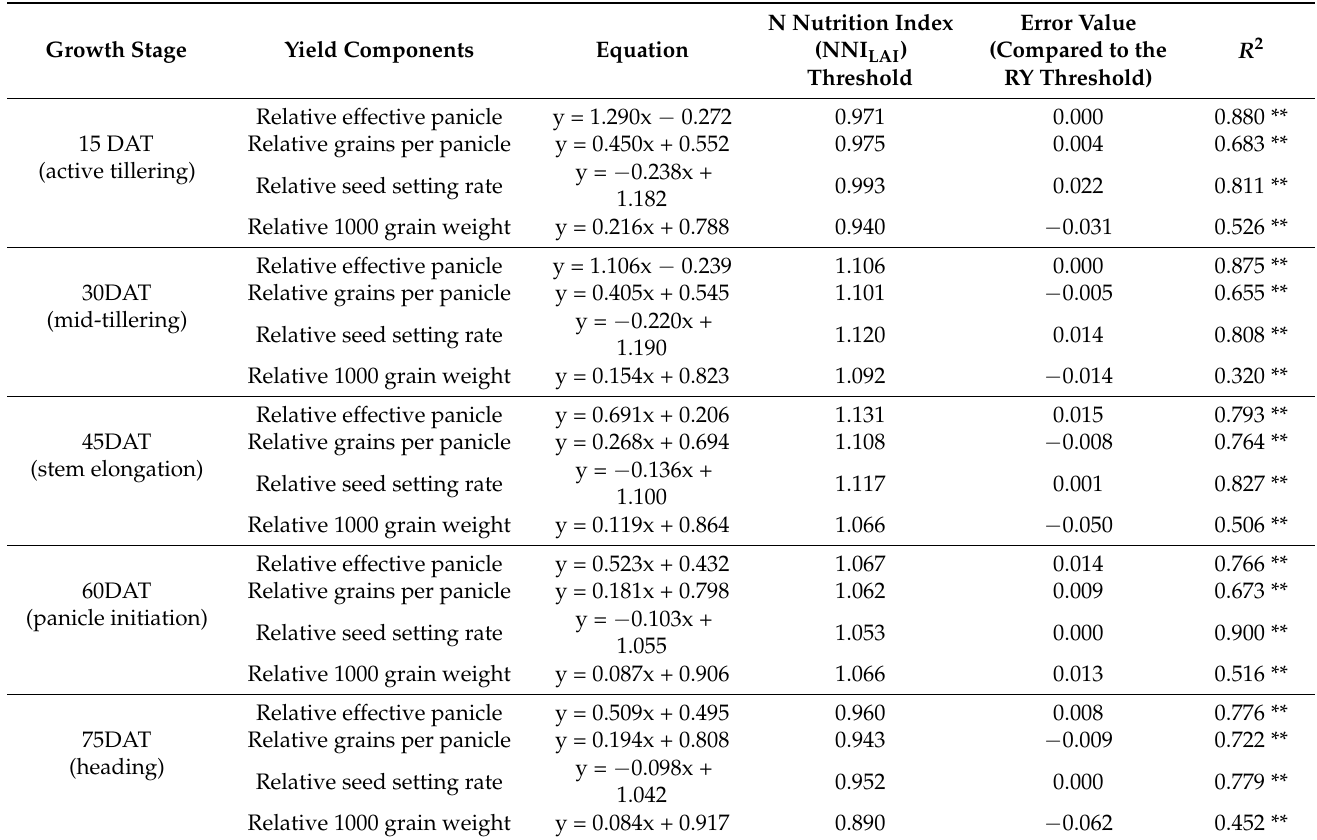
Table 3. Correlation between the NNI LAI and the relative yield components of the indica hybrid rice grown from machine-transplanted bowl seedlings according to growth stage. ** indicates significance at 0.01